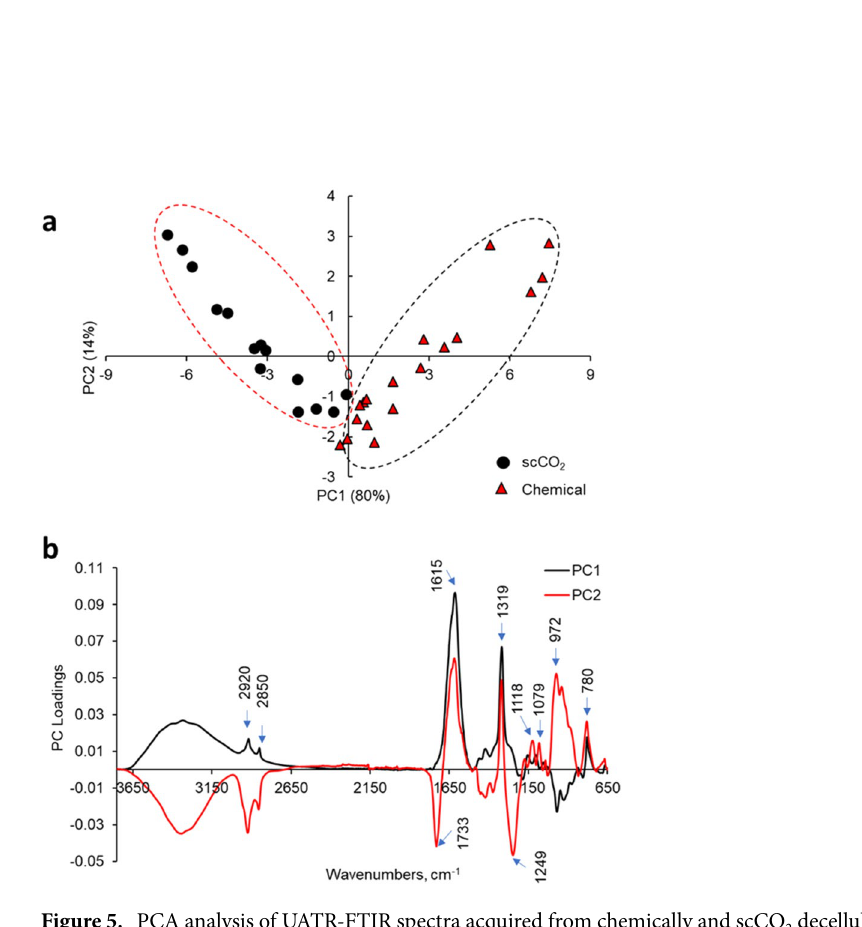
Figure 5. PCA analysis of UATR-FTIR spectra acquired from chemically and scCO 2 decellularized baby spinach leaves. ( a ) PCA score plot where each data point represents an individual spectrum. ( b ) PC1 and PC2 loadings as a function of wavenumbers (n =